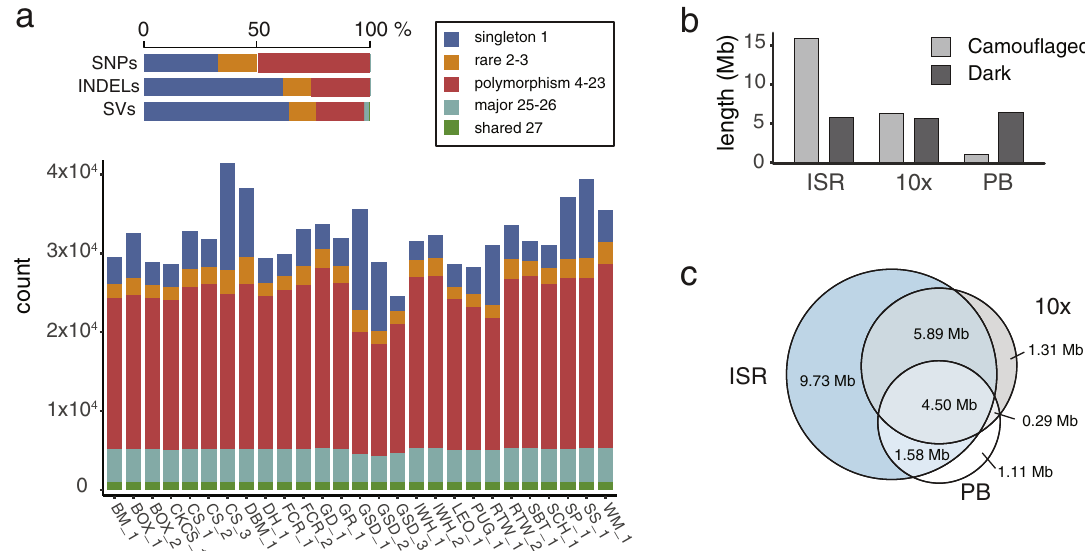
Fig. 3 Genome variation and dark/camou fl aged regions. a SNPs, indels and structural variations shared among Mischka and the 27 10x sequenced dogs. b The total length of dark and camou fl aged regions detected from Illumina short reads (ISRs), 10x and PacBio sequencing. c Intersection of merged dark and camou fl aged regions from different